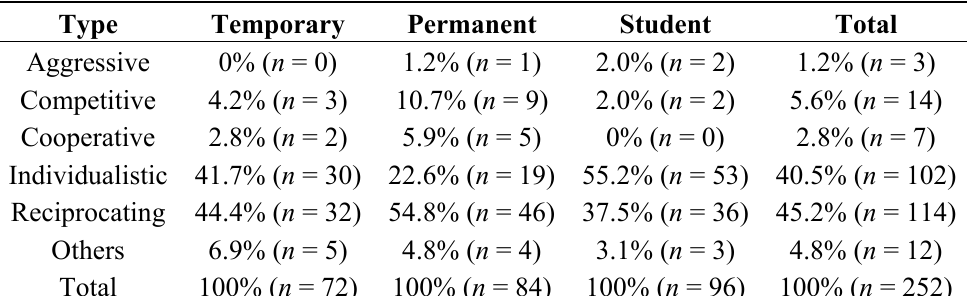
Table 5. Distribution of types in the three